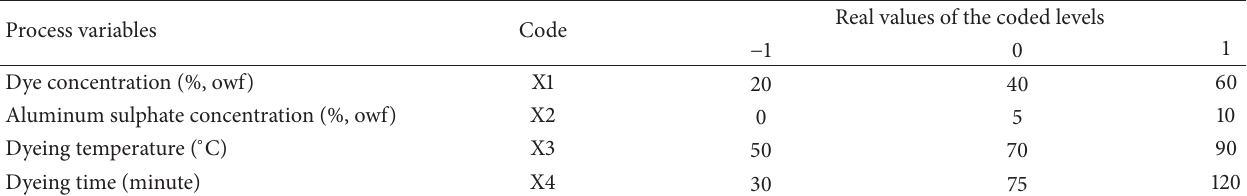
Table 1: Proposed experimental ranges of dyeing procedure and coded levels of independent variable factors. Process